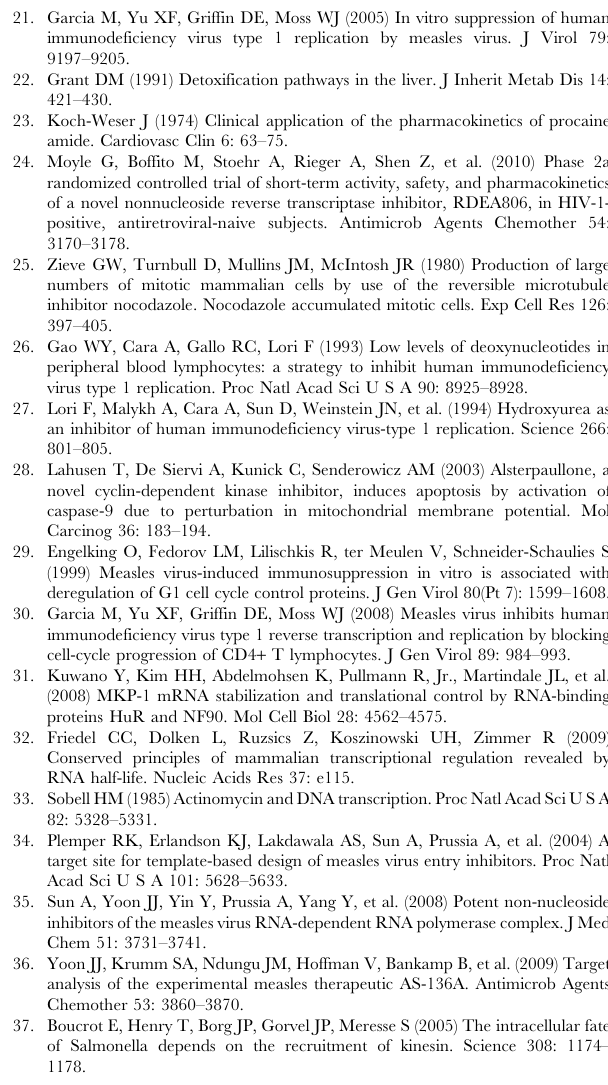
Figure S1 Synthesis of JMN3-003, JMN5-165 and JMN5-166. ( D )